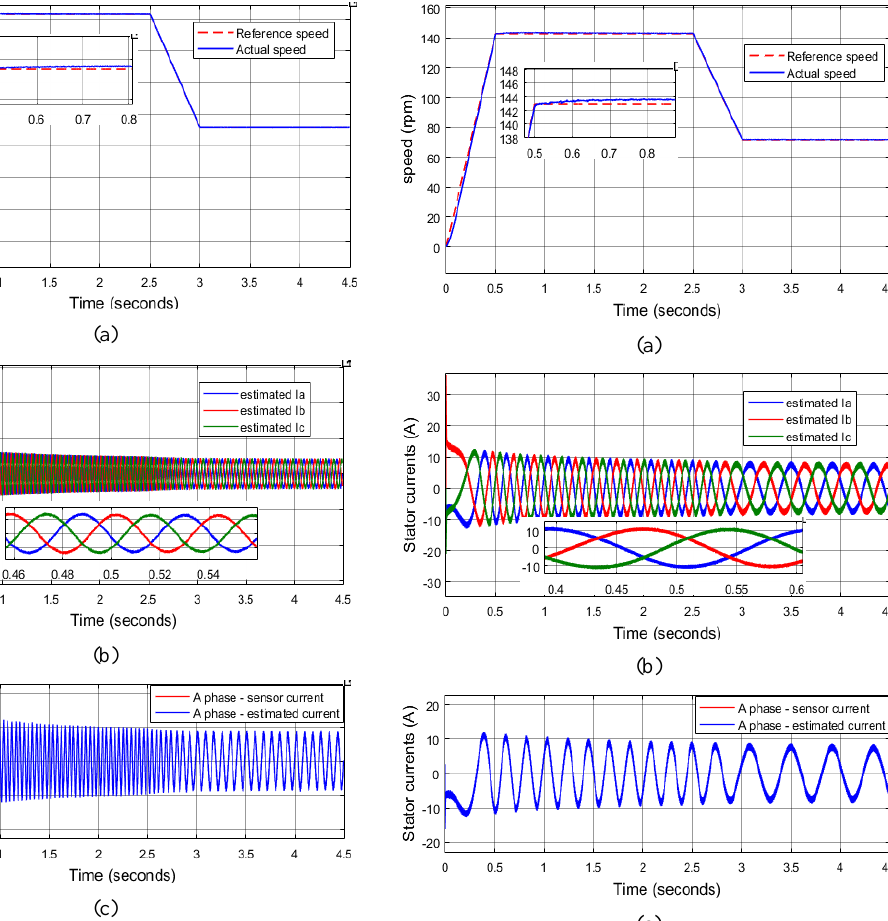
Fig. 6. HPWM technique without current sensors at no load condition: (a) Reference and actual speed at 50% - 25% rating Fig. 6: HPWM technique without current sensors at no Fig. 7. HPWM technique without current sensors at no load condition: (a) Reference and actual speed at 10% - 5% speed, (b) Three phase estimated currents, (c) Comparison between A phase measured current and estimated current. Fig. 7: HPWM technique without current sensors at no load condition: (a) Reference and actual speed rating speed, (b) Three phase estimated currents, (c) Comparison between A phase measured current and estimated current. load condition: (a) Reference and actual speed at 50% - 25% rating speed, (b) Three phase at 10% - 5% rating speed, (b) Three phase es- estimated currents, (c) Comparison between A timated currents, (c) Comparison between A phase measured current and estimated current. phase measured current and estimated